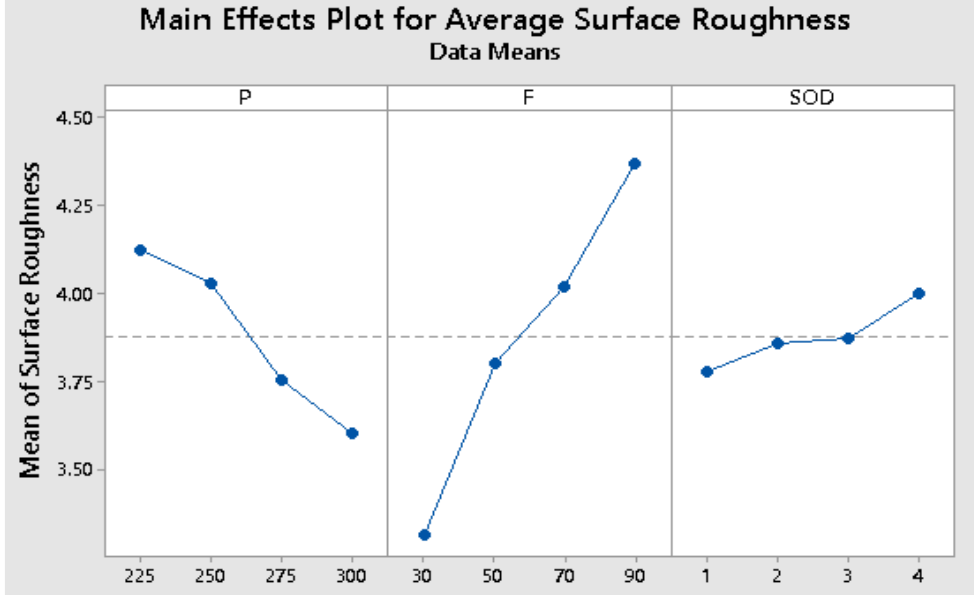
Figure 7: Main influence for average surface roughness.